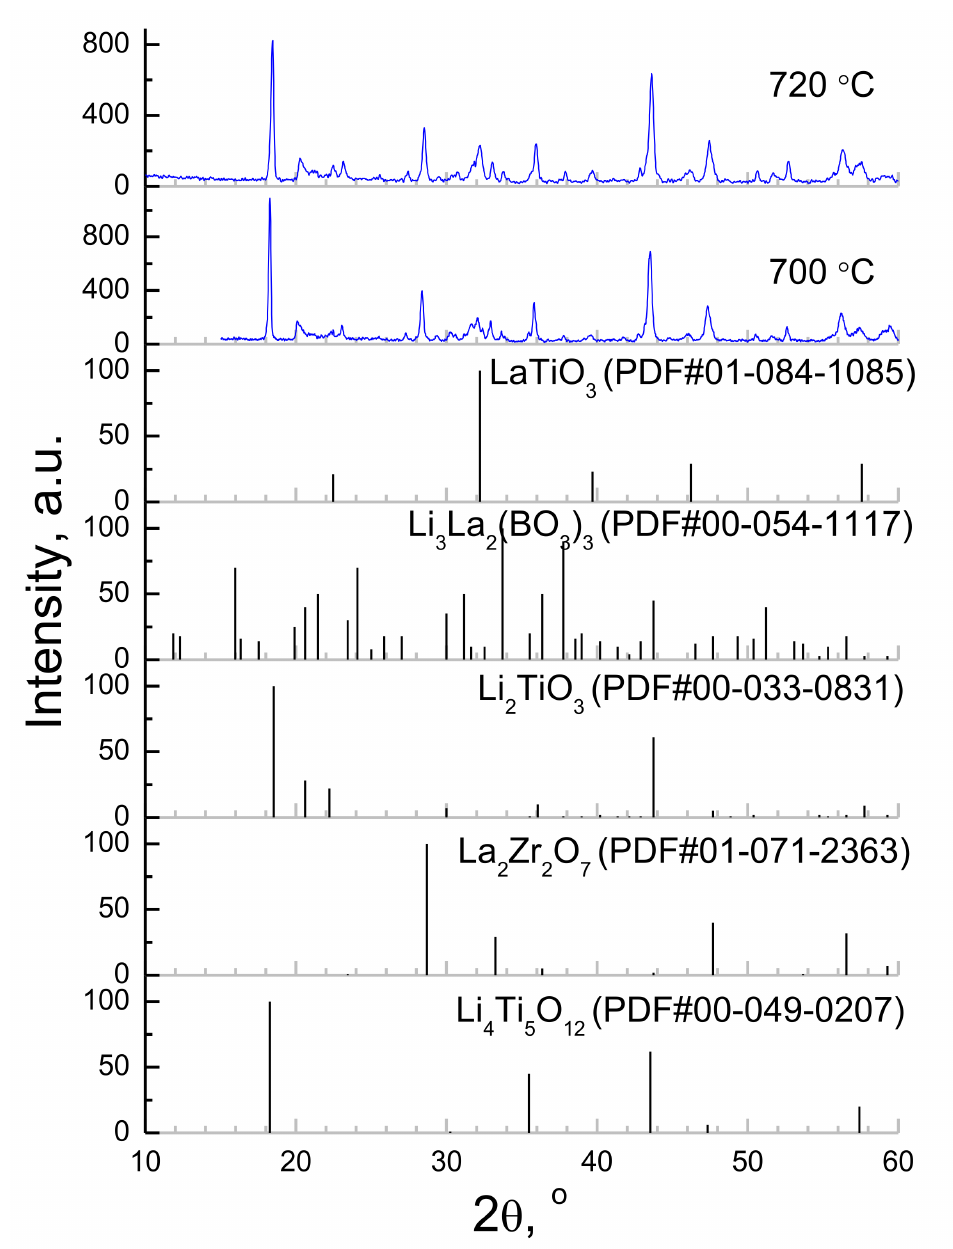
Figure 8. XRD patterns of Li 4 Ti 5 O 12 +5 wt%Li 3 BO 3 composite anode after sintering onto c-LLZ substrate at 700 and 720 ◦